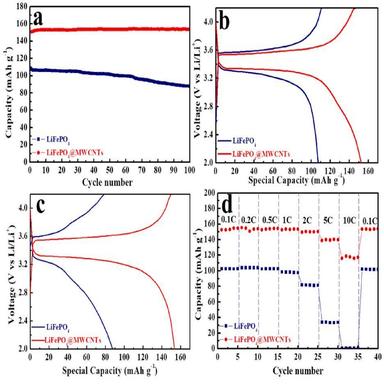
Cycle performance (a); Initial charge-discharge curves at 1C (b); The charge-discharge curves for 100 cycles (c) and the rate performance (d) of LiFePO4 and LiFePO4@MWCNTs composite.